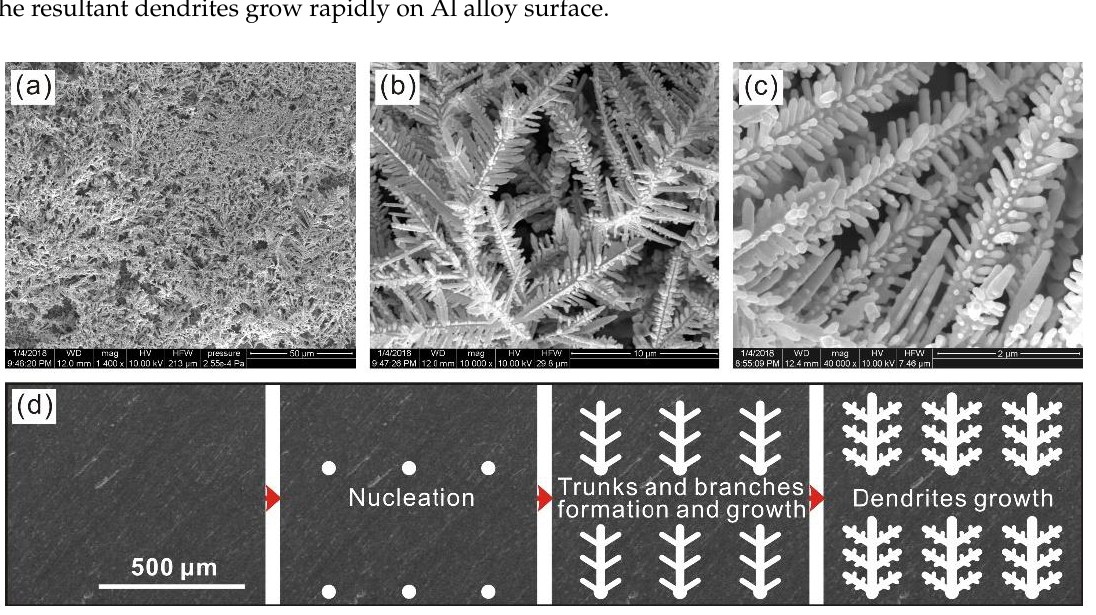
Figure 1. ( a – c ) SEM images of deposited Al alloys; ( d ) the growth process diagram of dendrites on Al alloy substrate.